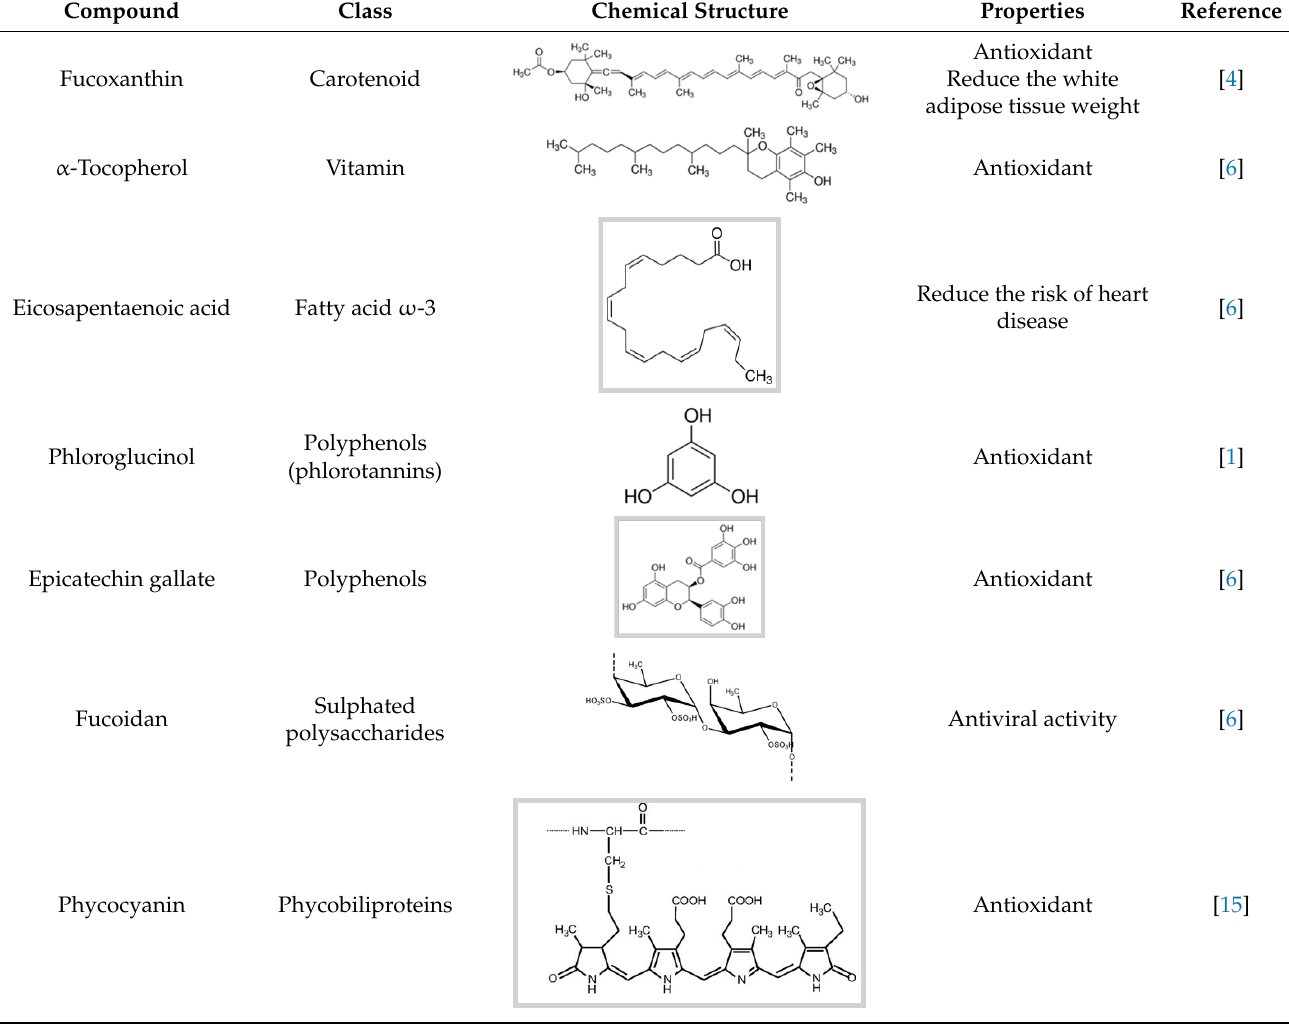
Table 1. Examples of the bioactive compounds identified in seaweeds.